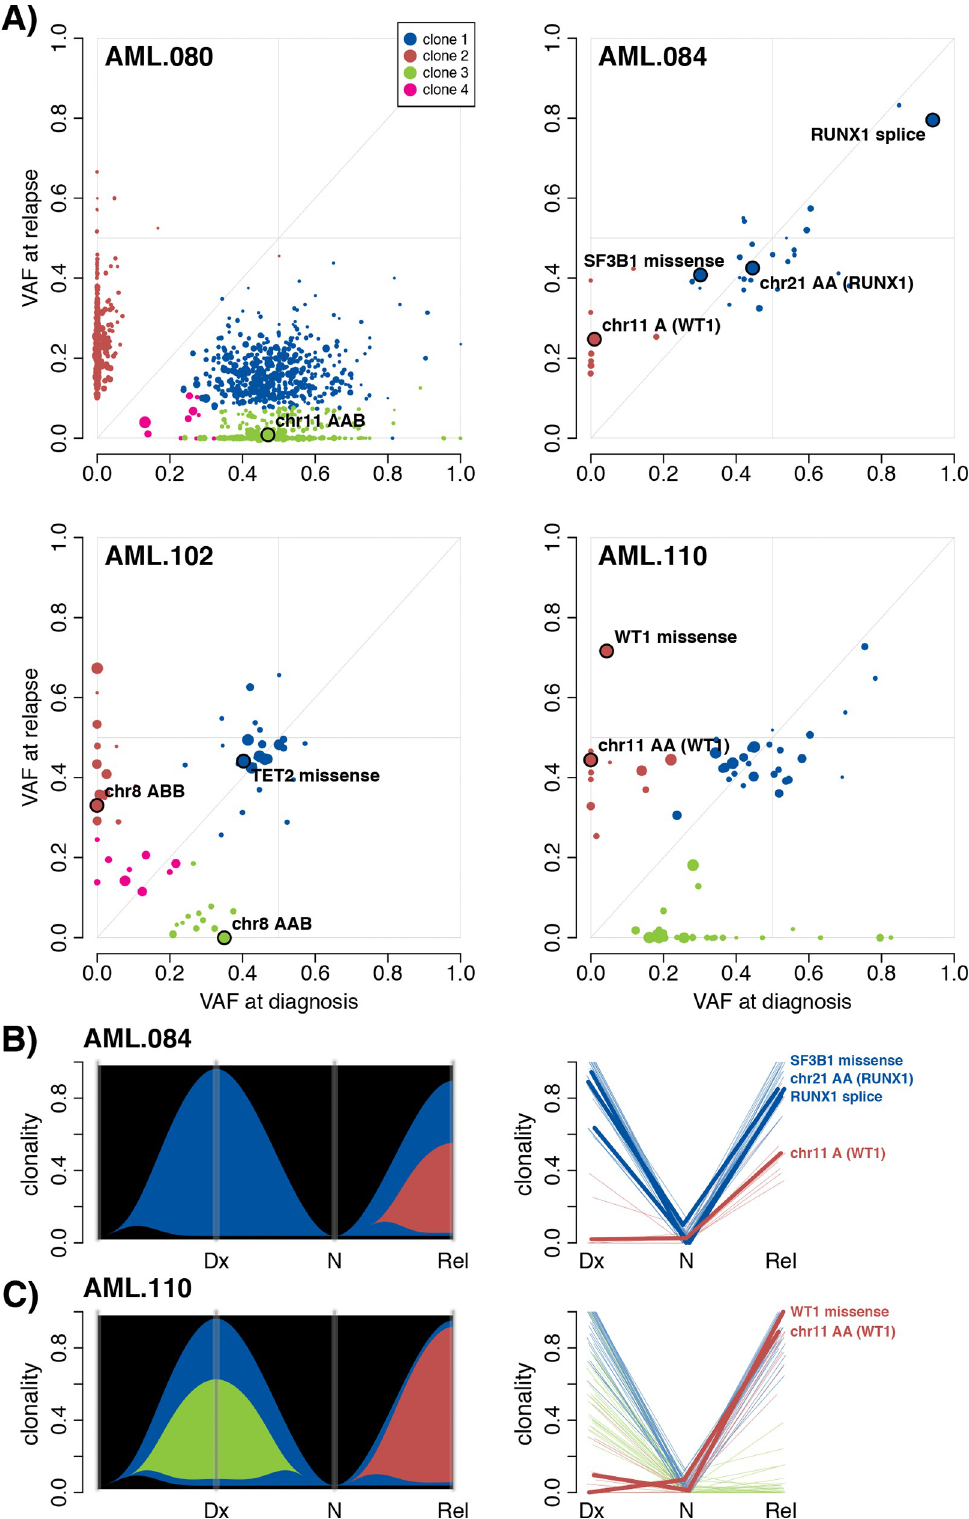
Fig 5. Assessment of clonal structure in AML using SuperFreq. (A) Clone scatter plots of four AML patients. The VAF is shown for all somatic point mutations that are tracked by SuperFreq, coloured by the clone they are assigned